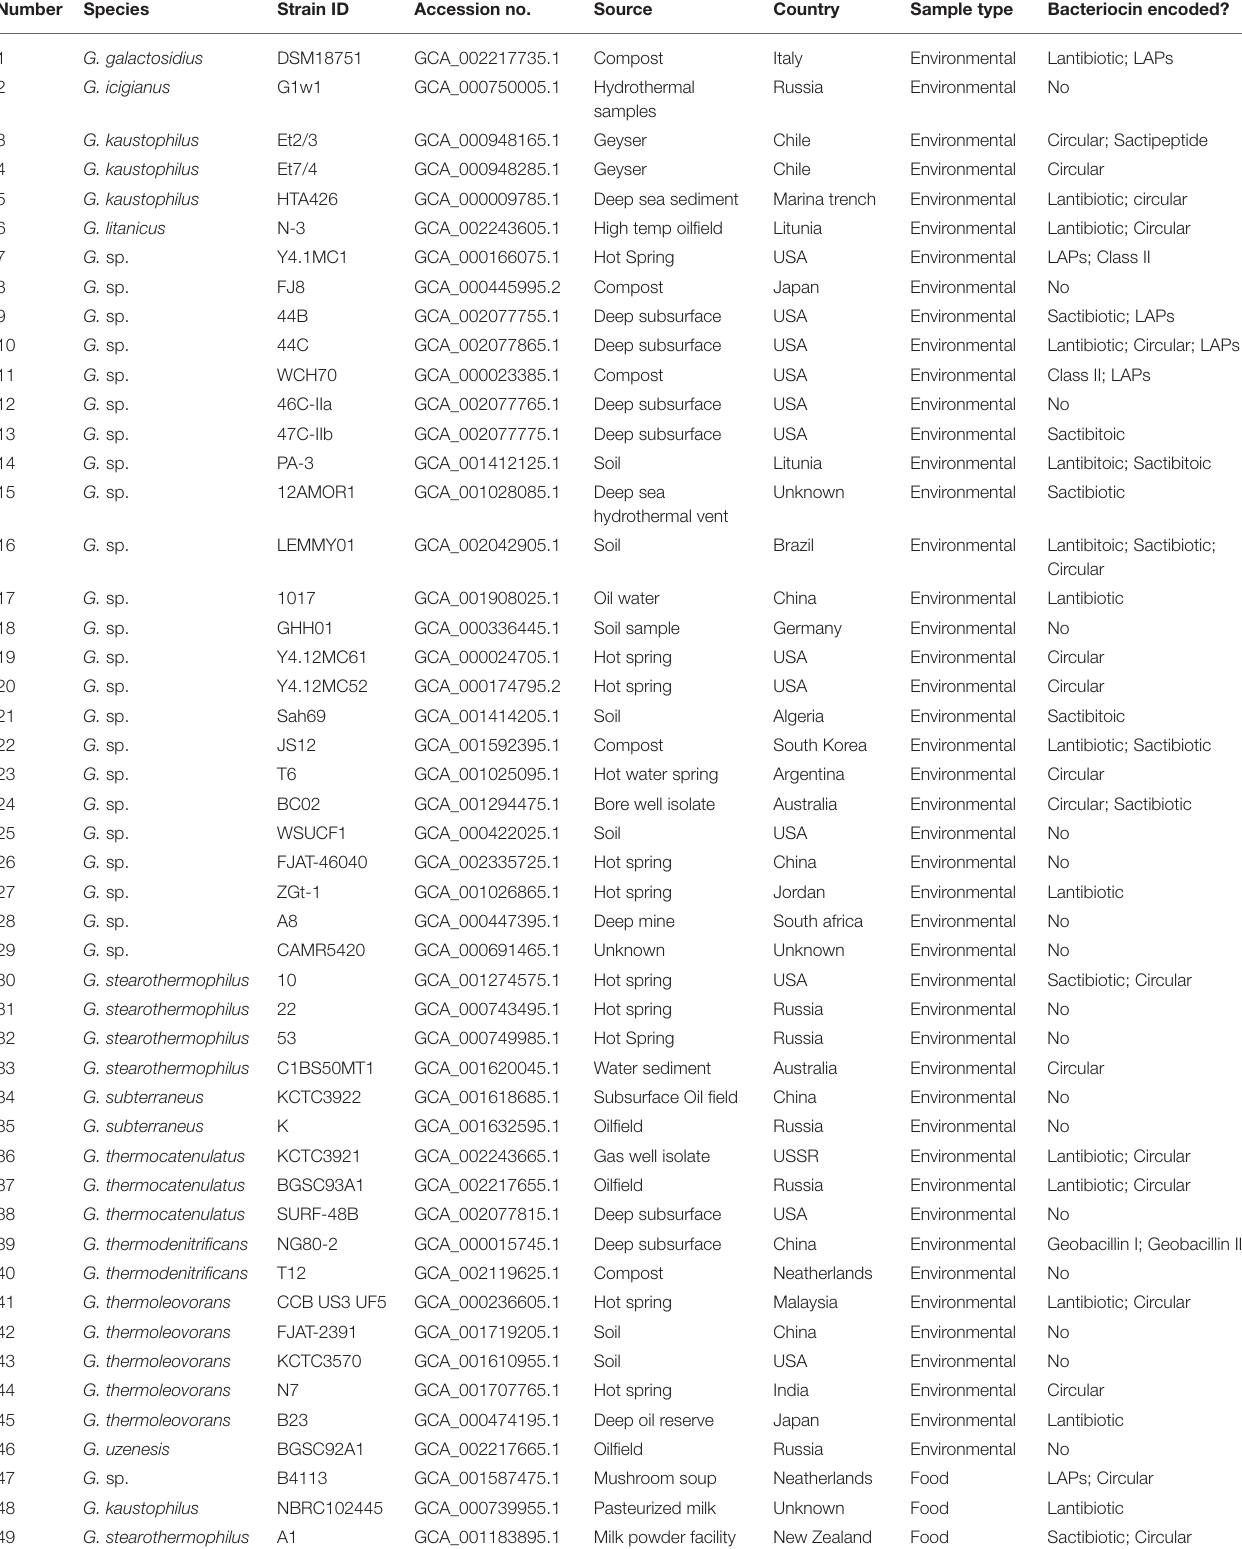
TABLE 1 | List of Geobacillus genomes examined in this in silico screen. Number